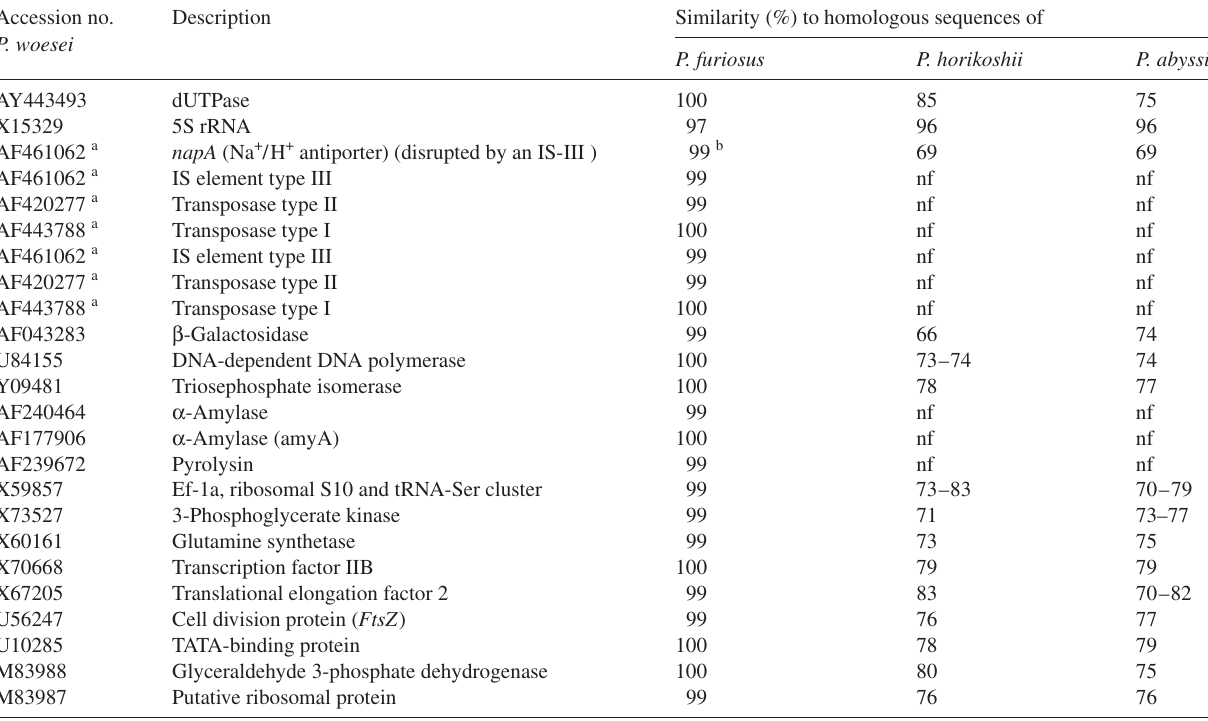
Table 1. BLAST results of nucleotide sequences from P. woesei against homologous sequences in the genomes of P. furiosus , P. horikoshii OT3 and P. abyssi. Abbreviation: nf = not